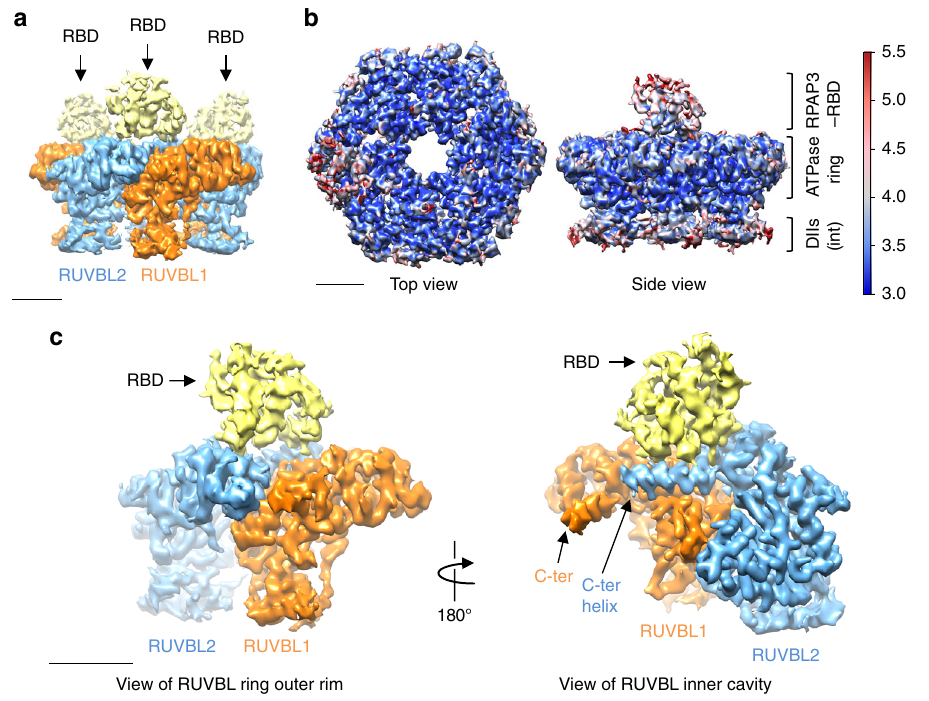
Fig. 4 Cryo-EM structure of RUVBL1 – RUVBL2 – RBD. a Top and side view of the cryo-EM density for the RUVBL1 – RUVBL2 – RBD complex containing 3 RBDs. RUVBL1 is colored in orange, RUVBL2 in blue, and RBD in yellow. Scale bar, 2.5 nm. b Top and side view of the 3.6 Å resolution structure of the RUVBL1 – RUVBL2 – RBD complex, processed as indicated in Methods, and displaying 1 RBD per RUVBL ring, and colored according to resolution difference from 3.0 to 5.5 Å 46 . Scale bar, 2.5 nm. c Two views of a 1:1:1 RUVBL1 – RUVBL2 – RBD complex, as seen from the inside or the outside of the RUVBL1 – RUVBL2 ring. The position of the C-terminal helices of RUVBL1 and RUVBL2 are indicated. Scale bar, 2.5